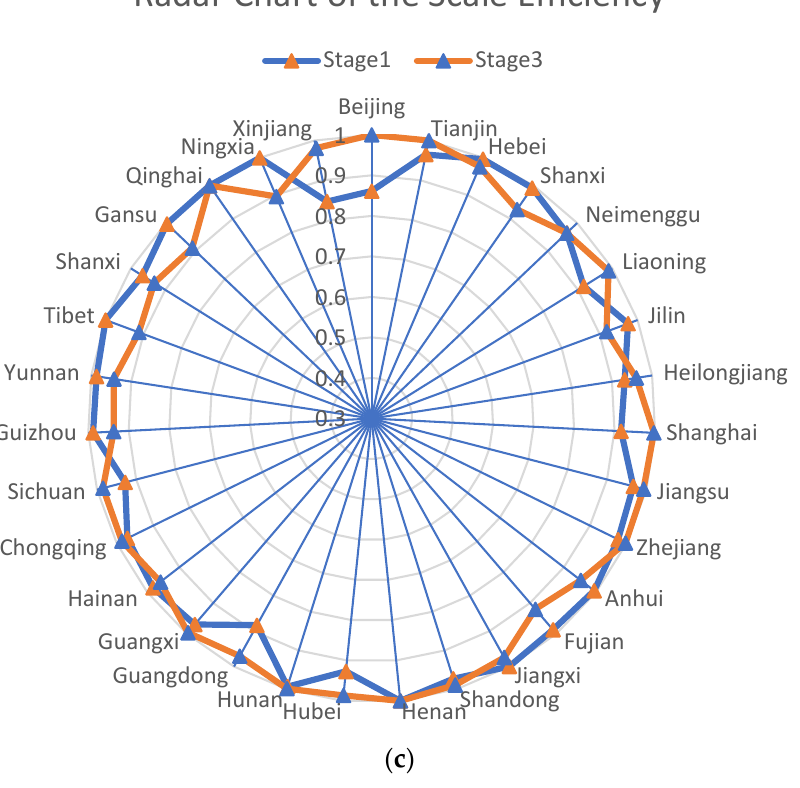
Figure 4. ( a ): Radar chart of the technical efficiency; ( b ): Radar chart of the pure technical efficiency; ( c ): Radar chart of the scale efficiency.